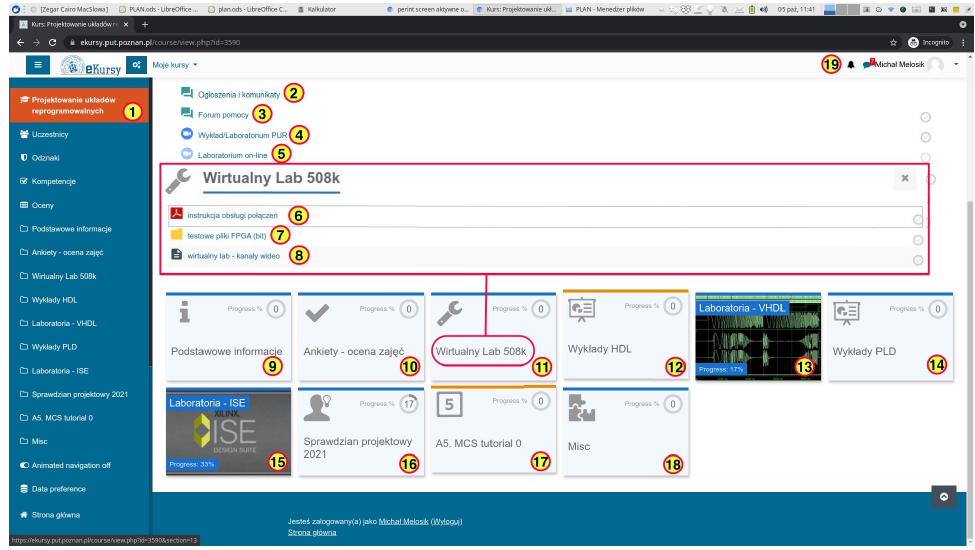
Figure 3. Screen of the home page of the Fundamentals of Digital Design and Synthesis course. The interface of the ’ekursy’ platform is in the Polish language. 1—Course name, 2—announcement section, 3—help forum, 4 and 5—links to the audio and video communicators, 6—remote connection procedure instruction, 7—FPGA programming test files, 8—section with embedded twich.tv